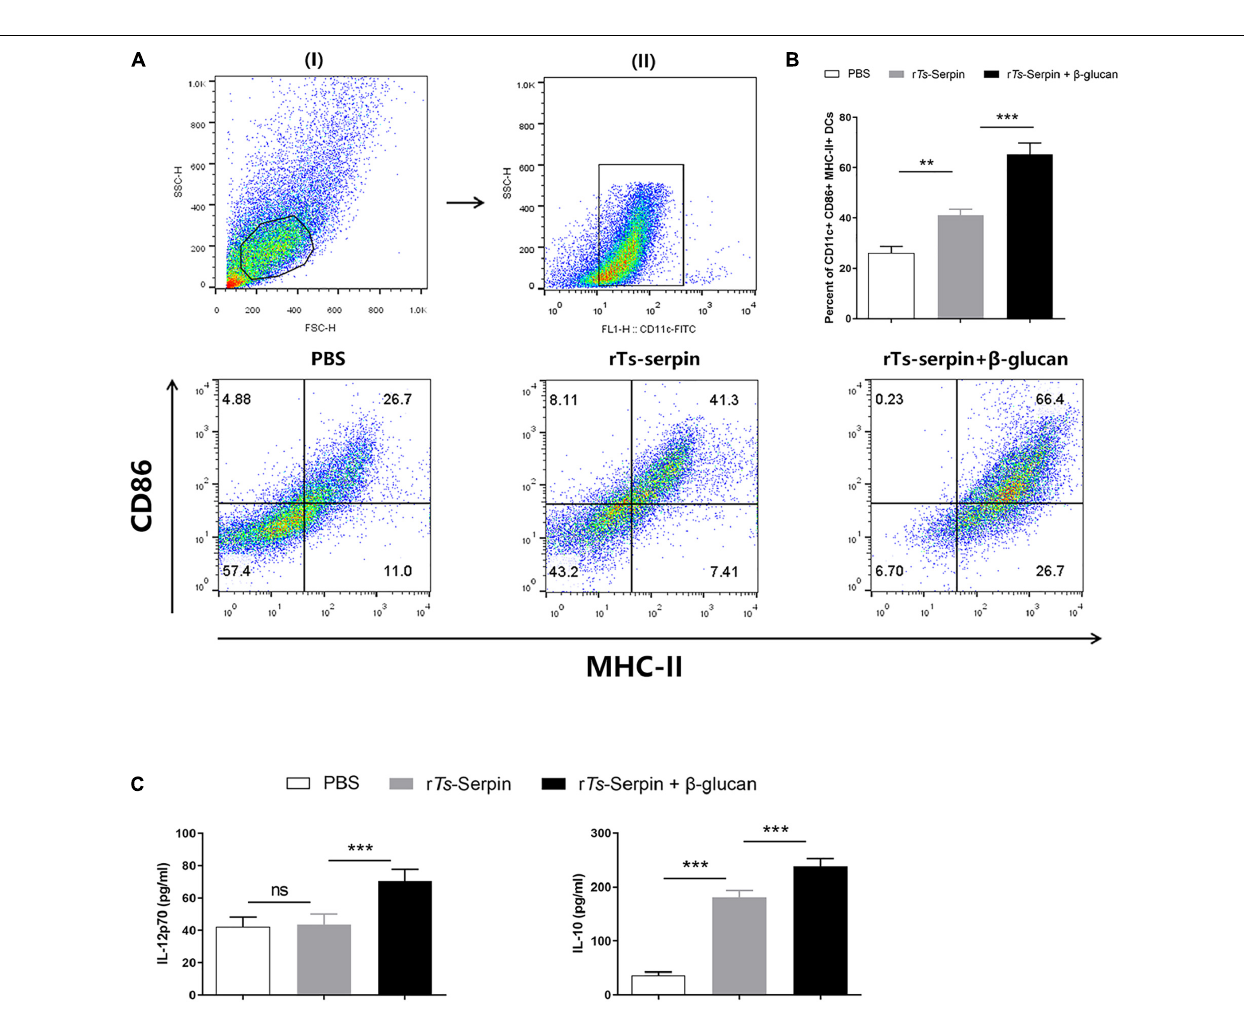
Frontiers in Cell and Developmental Biology |